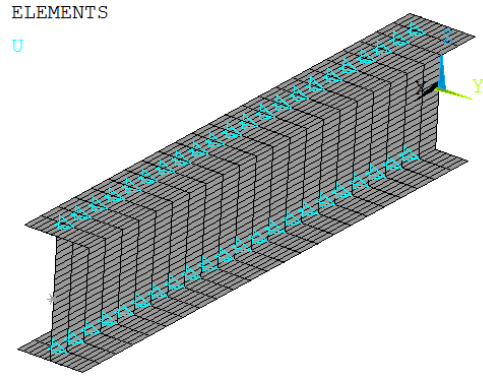
Figure 7. Lateral restraints of beam-columns.